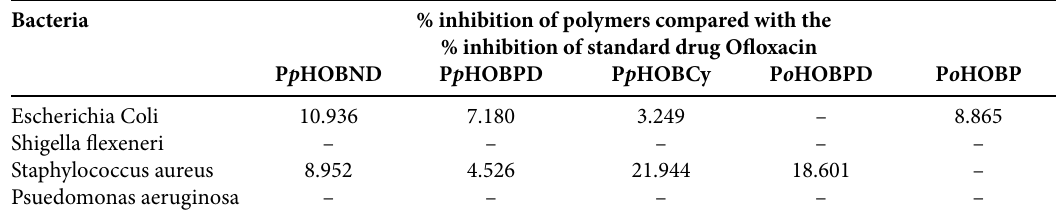
Table 6 : Results of antibacterial activities of polymers in DMSO Solvent Bacteria